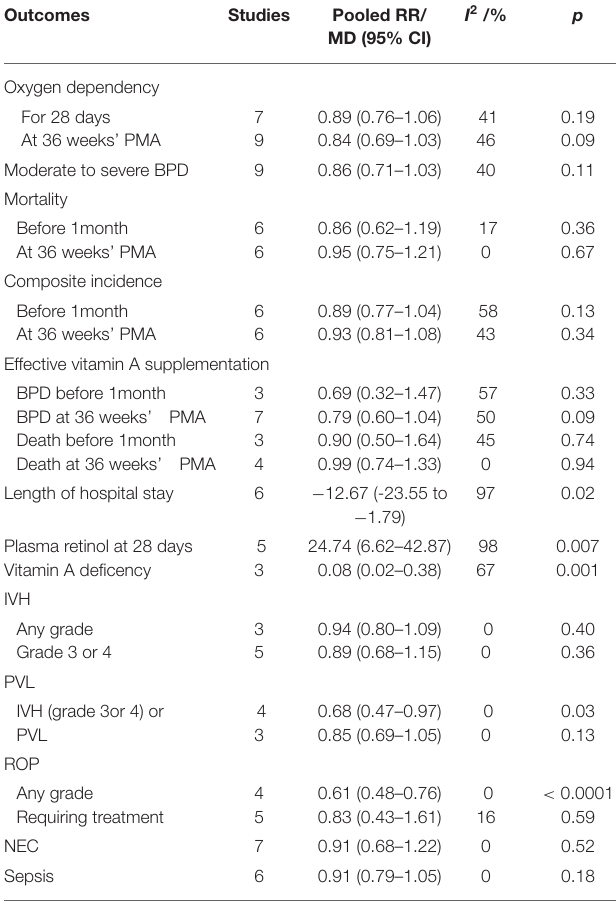
TABLE 2 | The main results of vitamin A supplementation and its